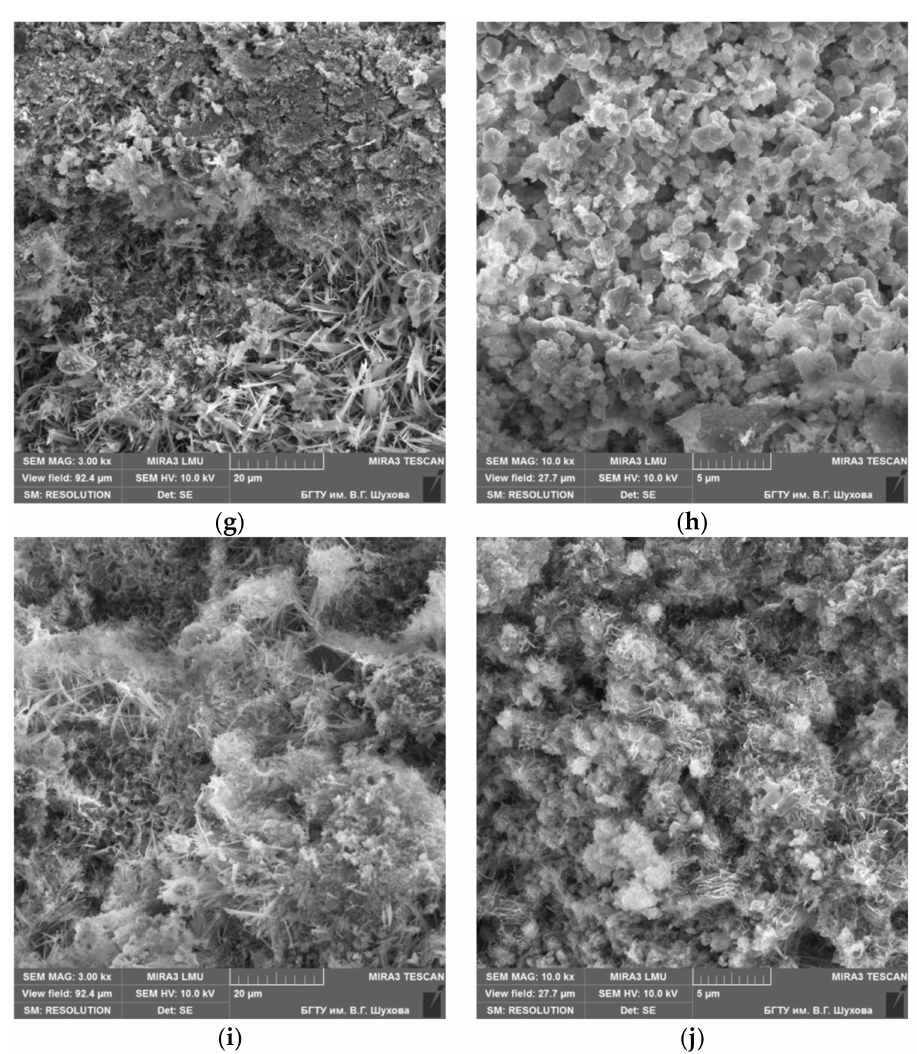
Figure 4. Microstructure of model samples with the ratio “quicklime/GMM”: ( a , b ) 1/1; ( c , d ) 1/1.5; ( e , f ) 1/2; ( g , h ) 1/2.5; ( i , j ) 1/3.